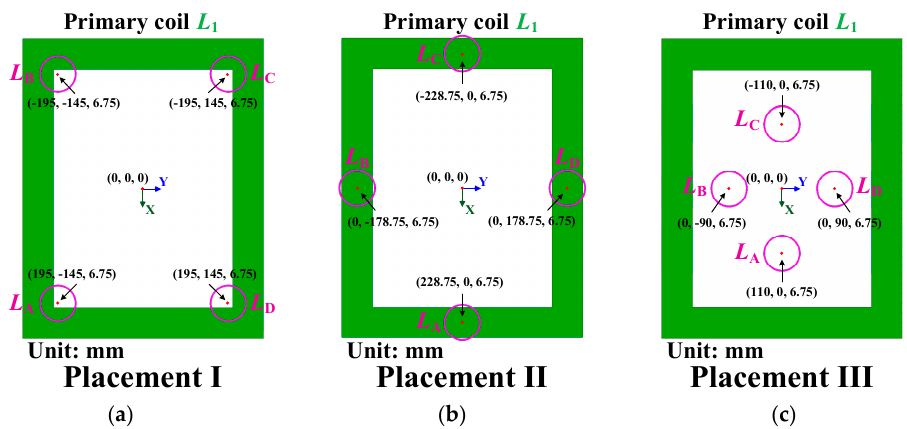
Figure 6. Three placements of auxiliary signal coils: ( a ) placed above four inner corners of the primary coil; ( b ) placed above four sides’ midpoints of the primary coil; ( c ) placed above the primary coil interior.